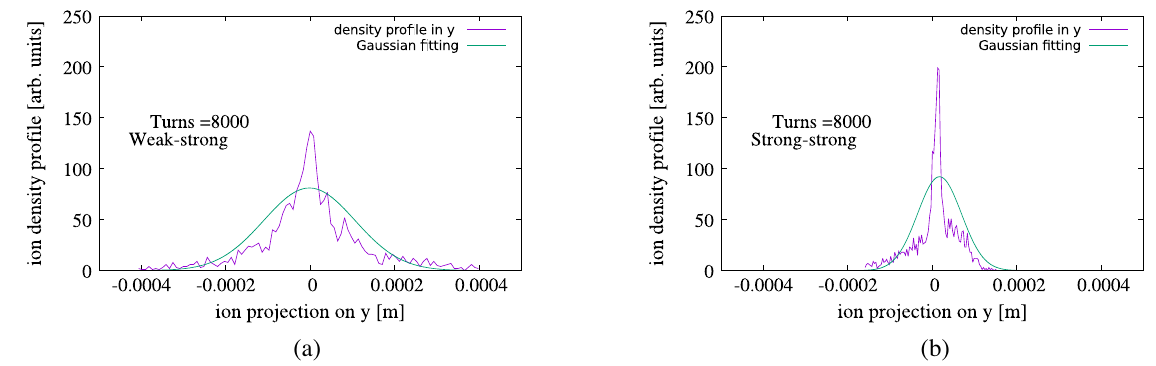
FIG. 8. The ion density profile comparison between simulations and Gaussian fitting in the vertical direction at the 8000th turn. Figures at left and right correspond to weak-strong and strong-strong simulations,